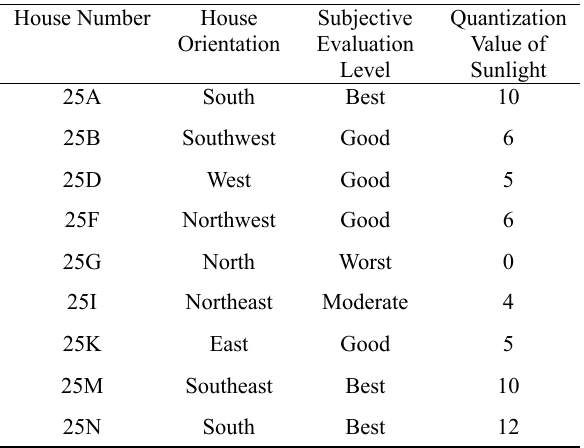
Table 4. Correlation Table of Sunlight